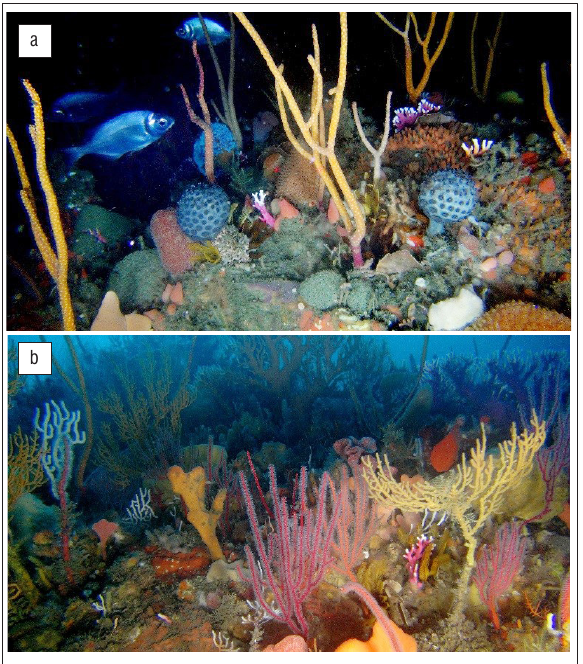
Figure 3: Algoa Bay is extraordinarily rich in invertebrate biodiversity. These images of benthic habitats were collected by a remotely operated vehicle at a depth of 50 m from (a) Evan’s Peak reef and (b) Riy Banks